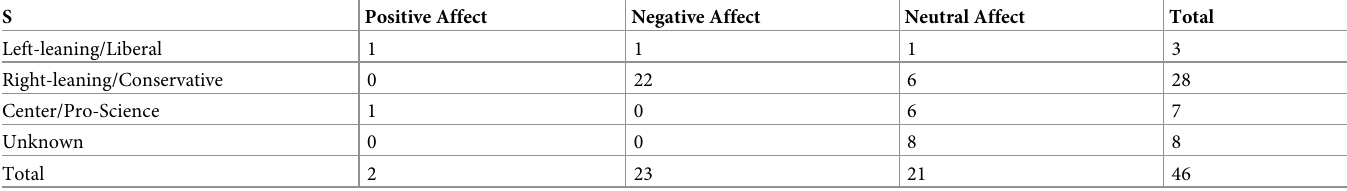
Table 2. Sentiment categorization by affect and political leaning.